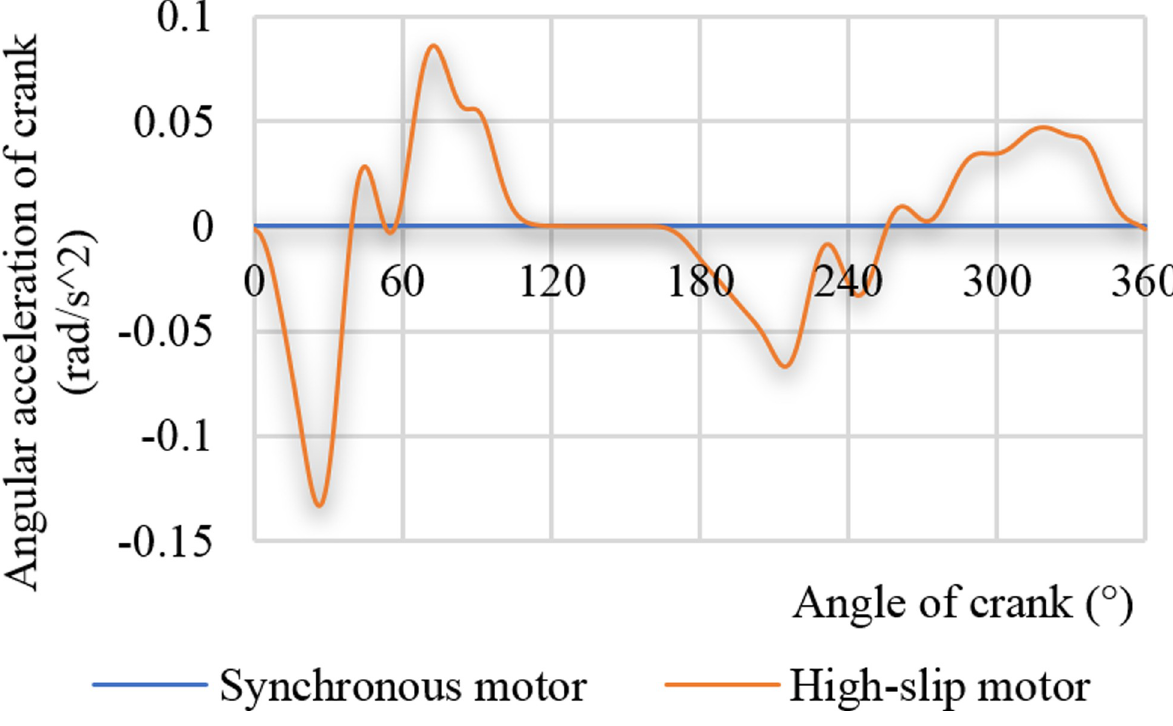
Fig 5. Angular acceleration curves of crank.